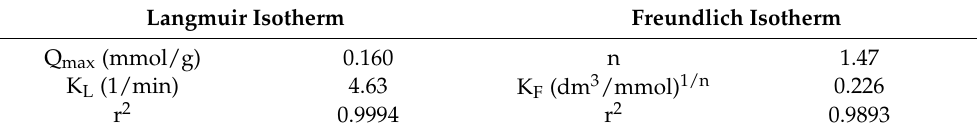
Table 5. The Langmuir and Freundlich parameters for adsorption of Cr(VI) ions on the AEAPTES- silica beads with 0.220 mmol/g in K 2 Cr 2 O 7 solutions at pH 3.0 and 30 ◦ C.